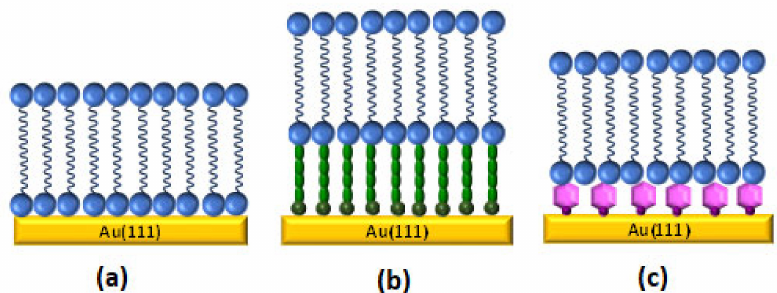
Figure 2. Cartoon of some type of biomimetic membranes at gold surface: ( a ) supported bilayer lipid membranes (sBLM), ( b ) tethered bilayer lipid membranes (tBLM), and ( c ) floating bilayer lipid membranes (fBLM). Adapted from [19] with permission from